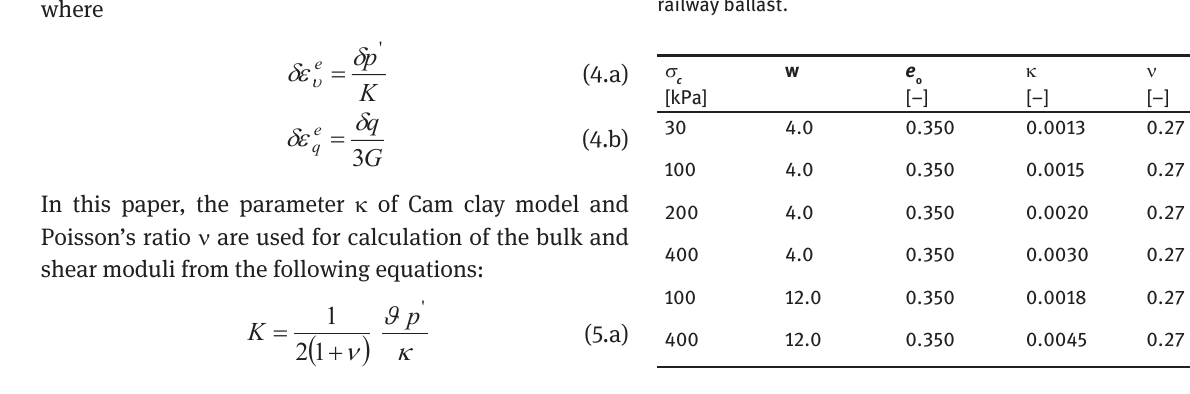
Table 2 : Experimental conditions and elastic parameters of fouled railway